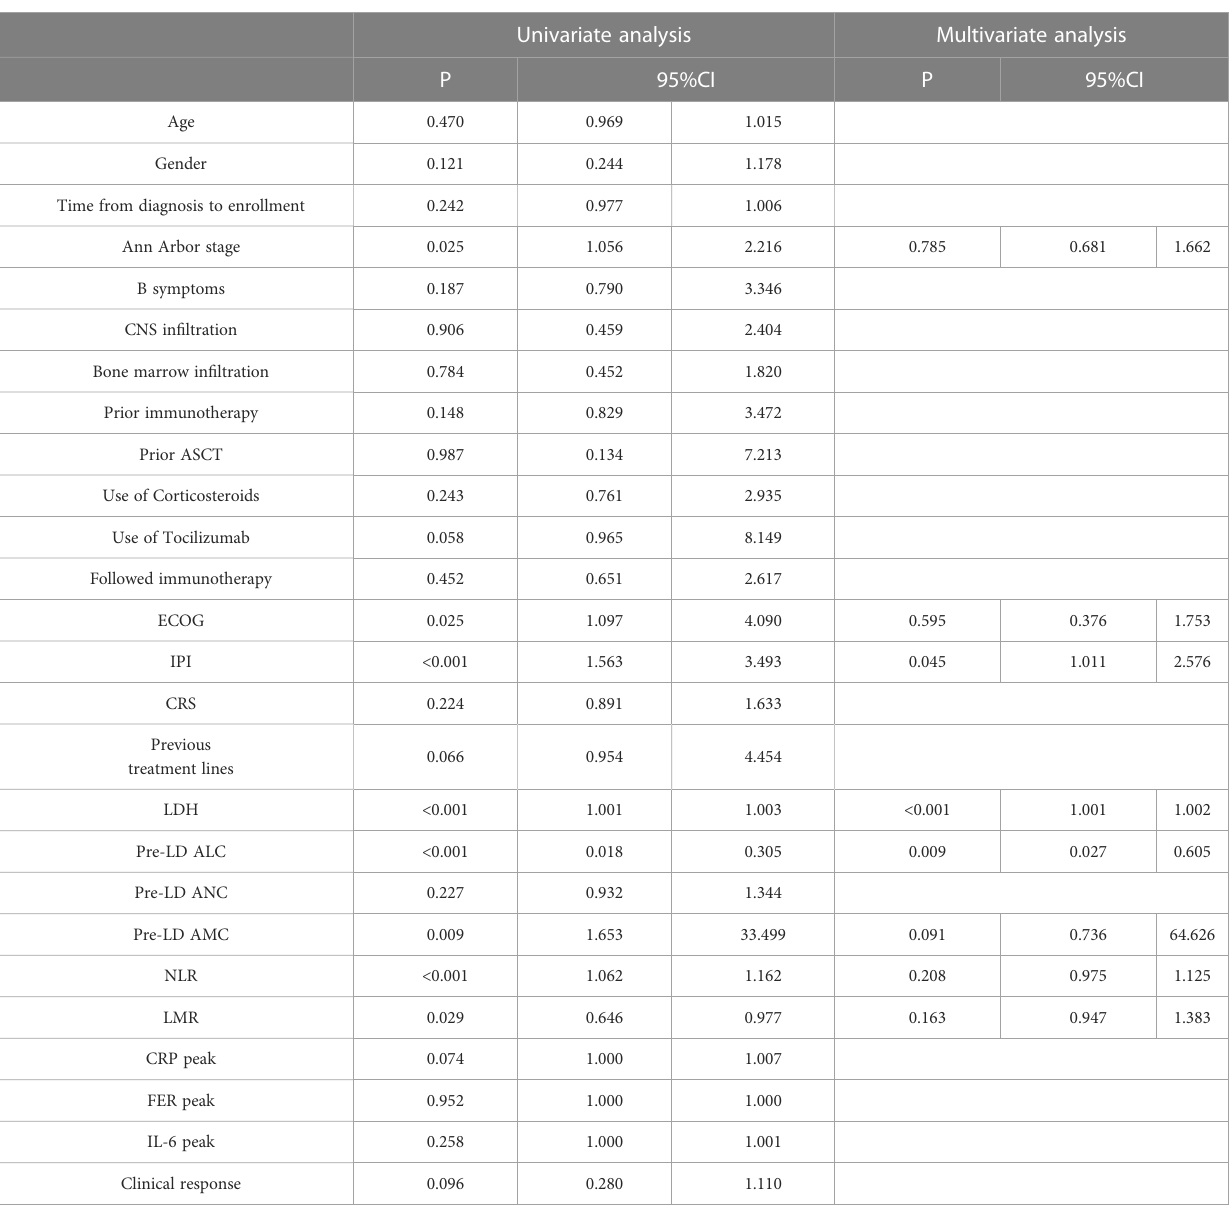
TABLE 3 Univariate and multivariate analysis of